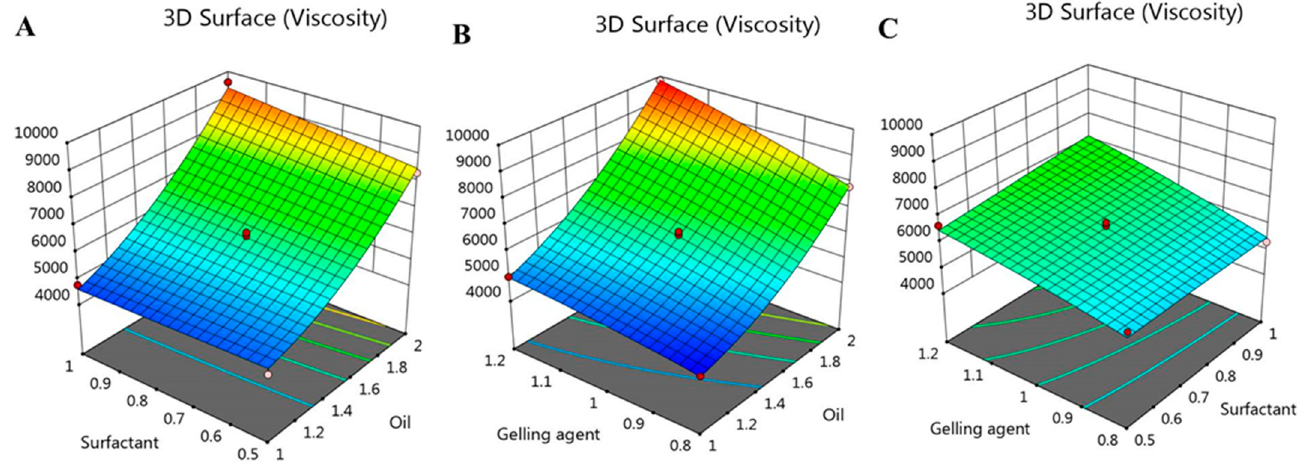
Figure 4. 3D-response surface plot representing the effect of independent factors ( A ) X 1 and X 2 , ( B ) X 1 and X 3 , and ( C ) X 2 and X 3 on viscosity responses (R 1 ).